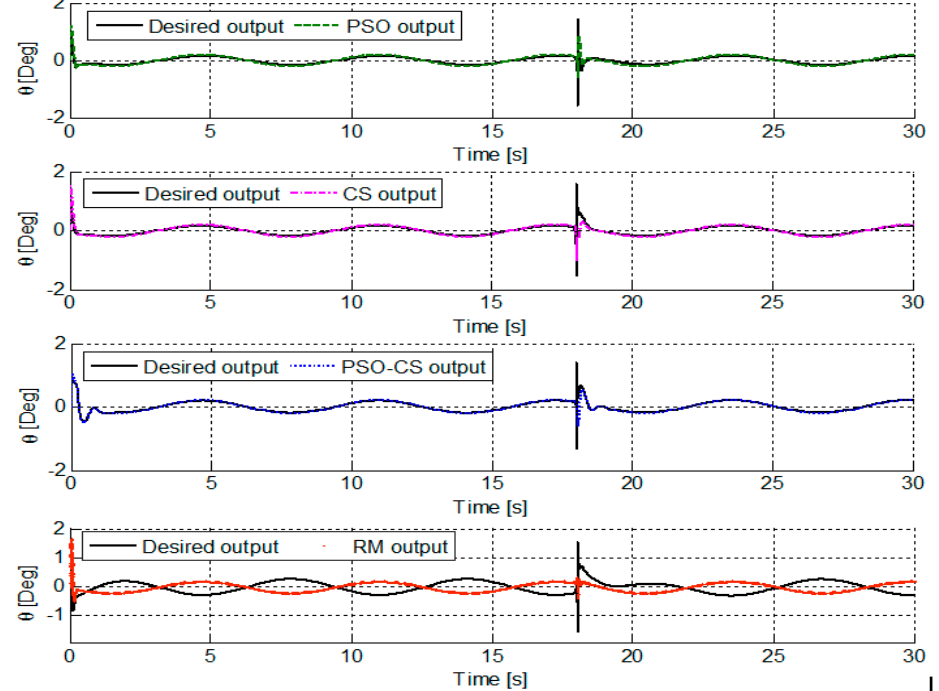
Figure 17. Quadrotor’s pitch attitude ( θ ) using Particle Swarm Optimization (PSO), Cuckoo Search (CS), Particle Swarm Optimization-Cuckoo Search (PSO-CS), and Reference Model (RM) (helical trajectory).